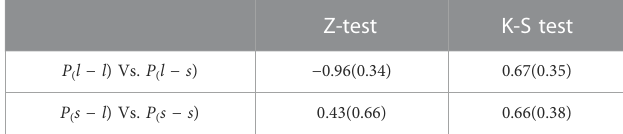
TABLE 1 The result of Z-test and K-S